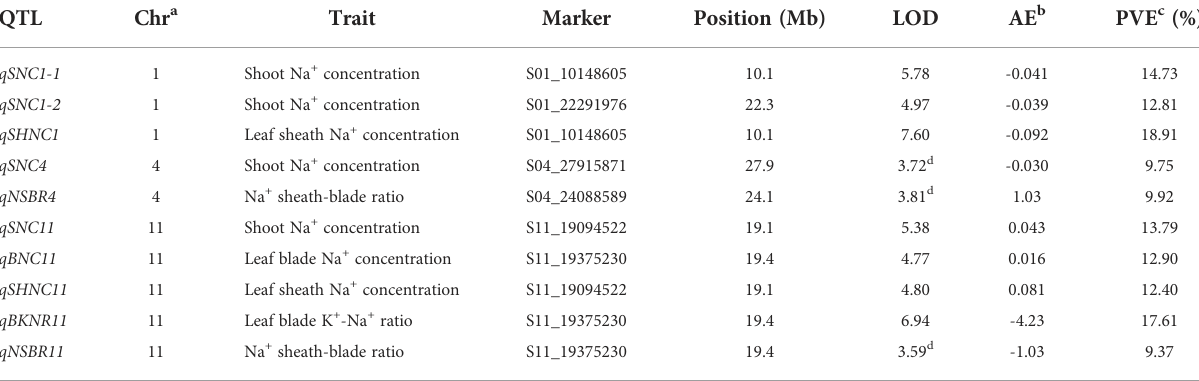
TABLE 1 QTL detected in F 2 generation for traits for Na + sheath-blade ratio and salt tolerance-related traits from the cross of IR-44595 and 318 in the presence of 30 mM NaCl in hydroponics at the seedling stage based on interval